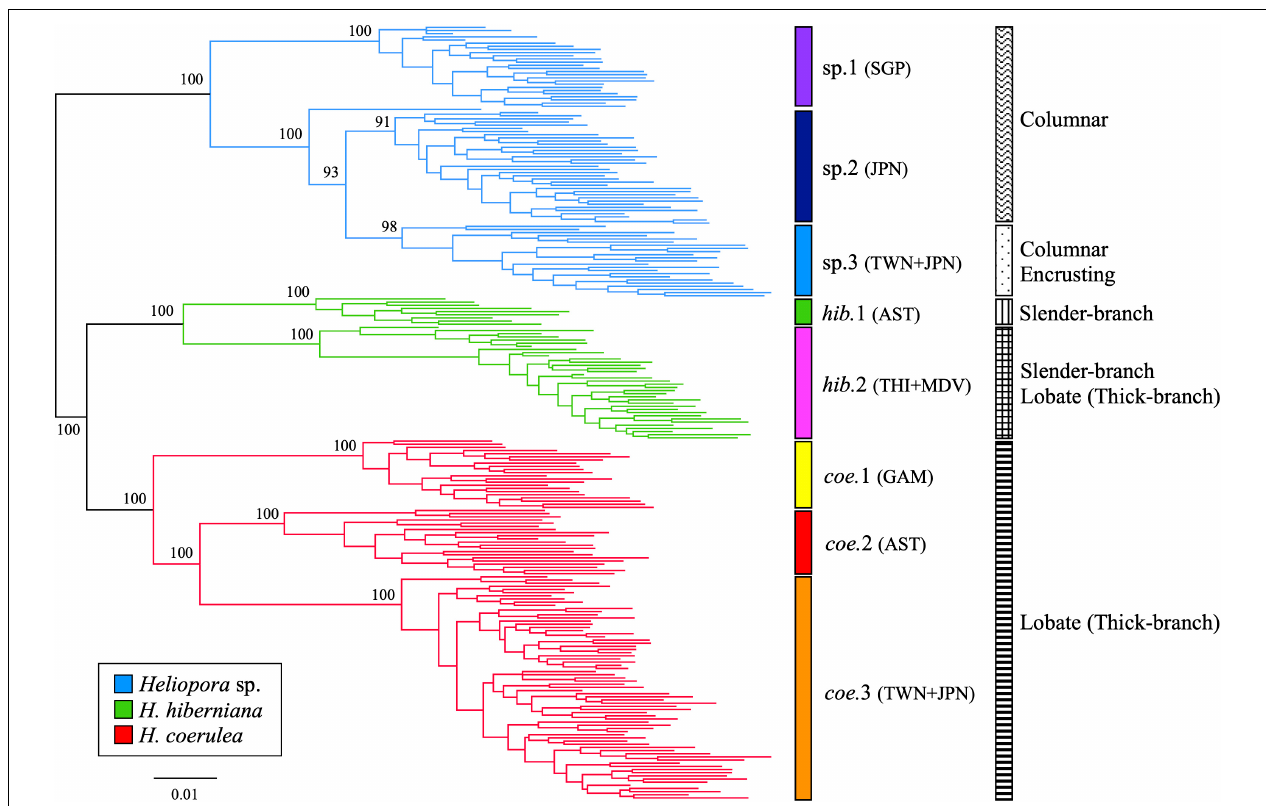
FIGURE 1 | Maximum likelihood phylogeny of Heliopora spp. Node supports are provided if bootstrap values (cid:61) 90%. Blue Heliopora sp. group composed of three subclades; Singapore subclade (sp.1), a subclade of HC-A with columnar growth form found in Japan (sp.2), and a subclade of HC-A with both encrusting and columnar growth forms found in Japan and Taiwan (sp.3). Green H. hiberniana group composed of two subclades; a subclade including the holotype of H. hiberniana found in northwestern Australia ( hib .1) and a Thailand and the Maldives subclade ( hib .2). Red H. coerulea group composed of three subclades; Guam subclade ( coe .1), a subclade of H. coerulea in northwestern Australia ( coe .2), and a subclade of HC-B found in Japan and Taiwan ( coe .3).